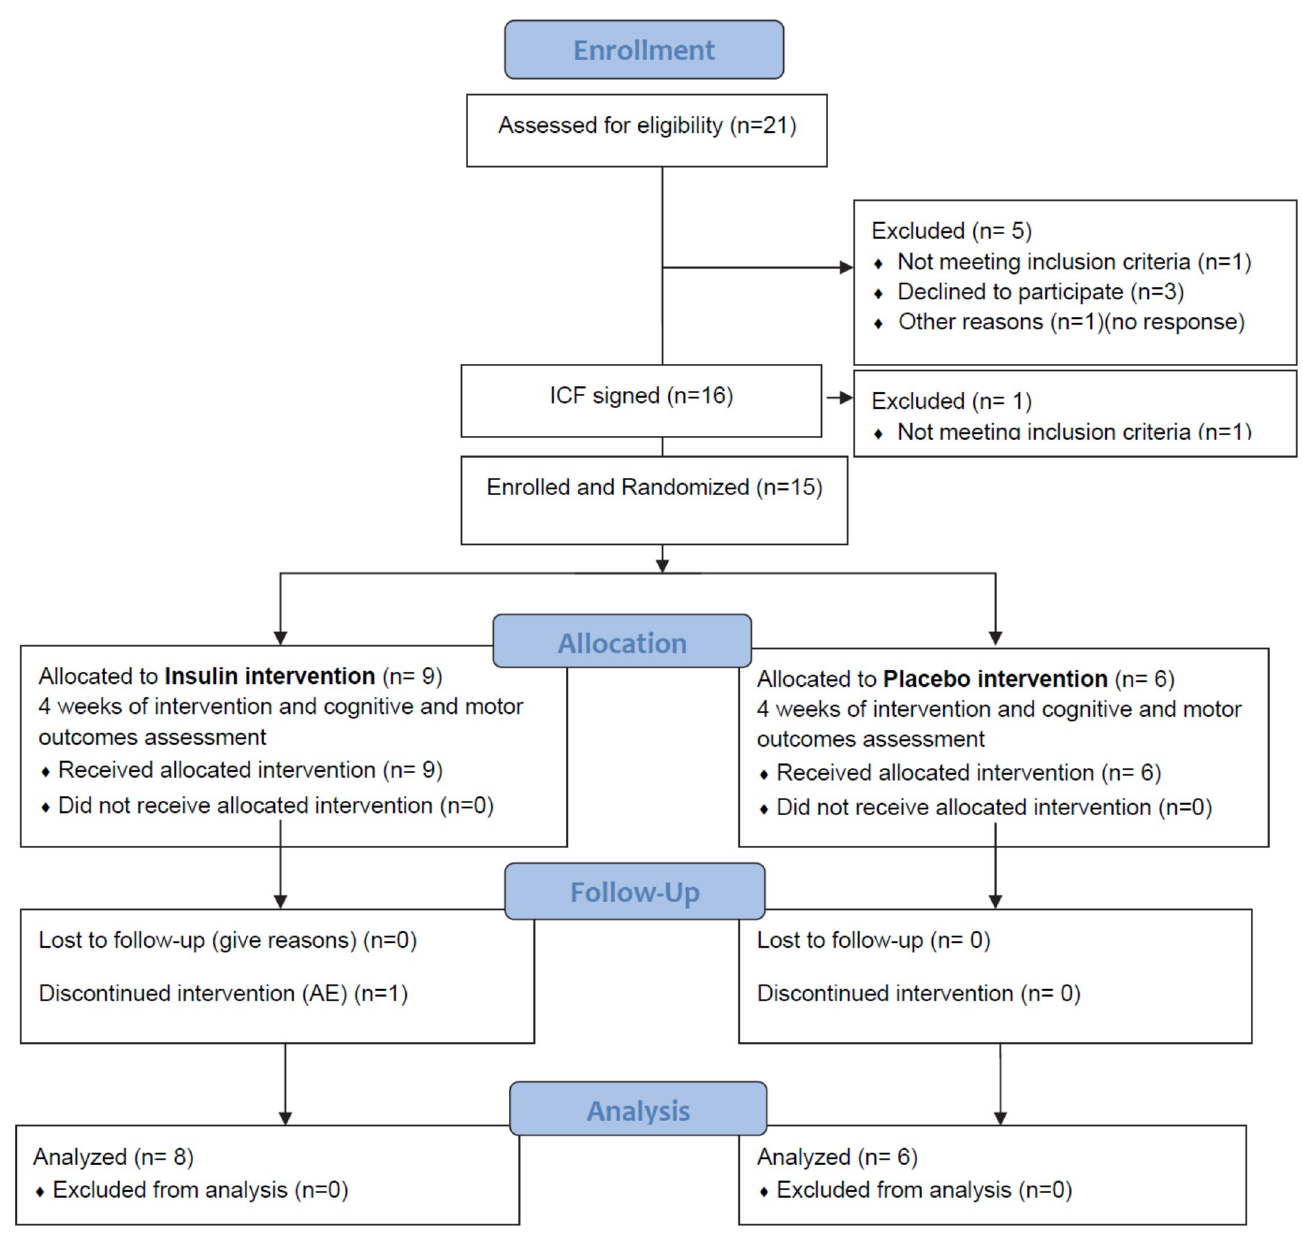
Fig 1. Study flow